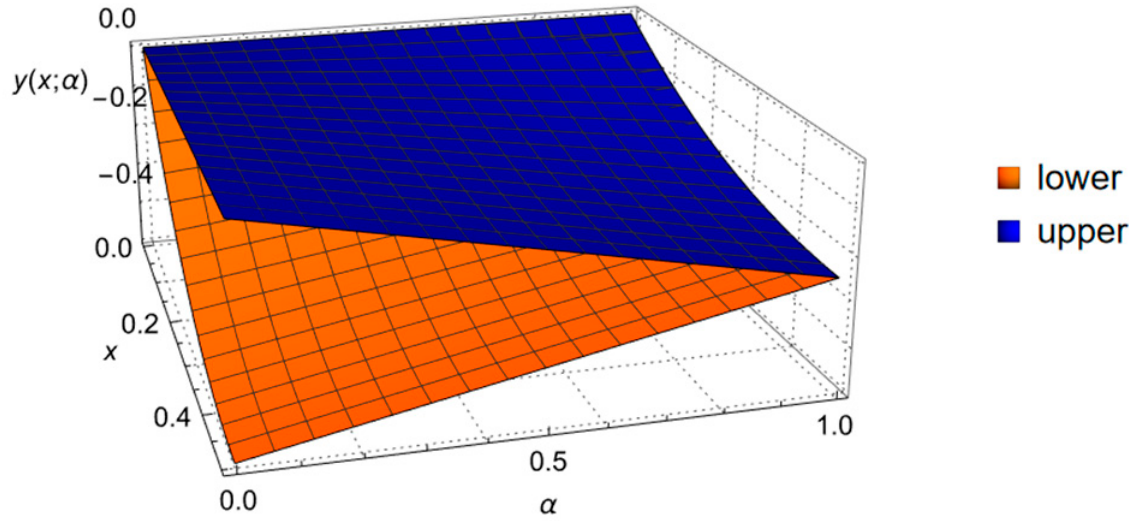
Figure 1. The three-dimensional approximate solution of Equation (31) given by the third-order FF-OHAM over all x ∈ [ 0,0.5 ] , and for all α ∈ [ 0,1 ] . To analyze the behavior of FF-OHAM for solving second-order FFOBVPs, we shall proceed to solve Equation (31) using the same data, x ∈ [ 0, 0.5 ] and ω = 1.5, and the fifth-order FF-OHAM instead of the third-order FF-OHAM to illustrate the convergence dynamic of FF-OHAM for different terms of the approximate series solution; therefore, the series solution will take the following